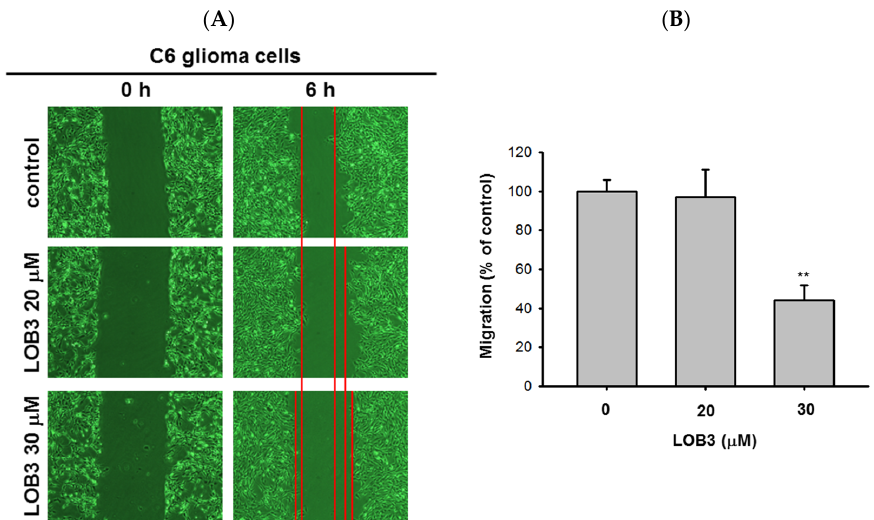
Figure 3. Anti-migratory effect of LOB3 in C6 cells. ( A ) Migration of C6 cells treated with the indicated doses of LOB3 for 6 h was analyzed under a light microscope. ( B ) Migration areas (% of control) were calculated and plotted with Figure 3A. Statistical significance was analyzed by the Mann-Whitney U test. Result ( A ) is a representative of three experiments. The data ( B ) are expressed as the means ± SD of three experiments. ** p < 0.01 compared to the vehicle-treated controls.